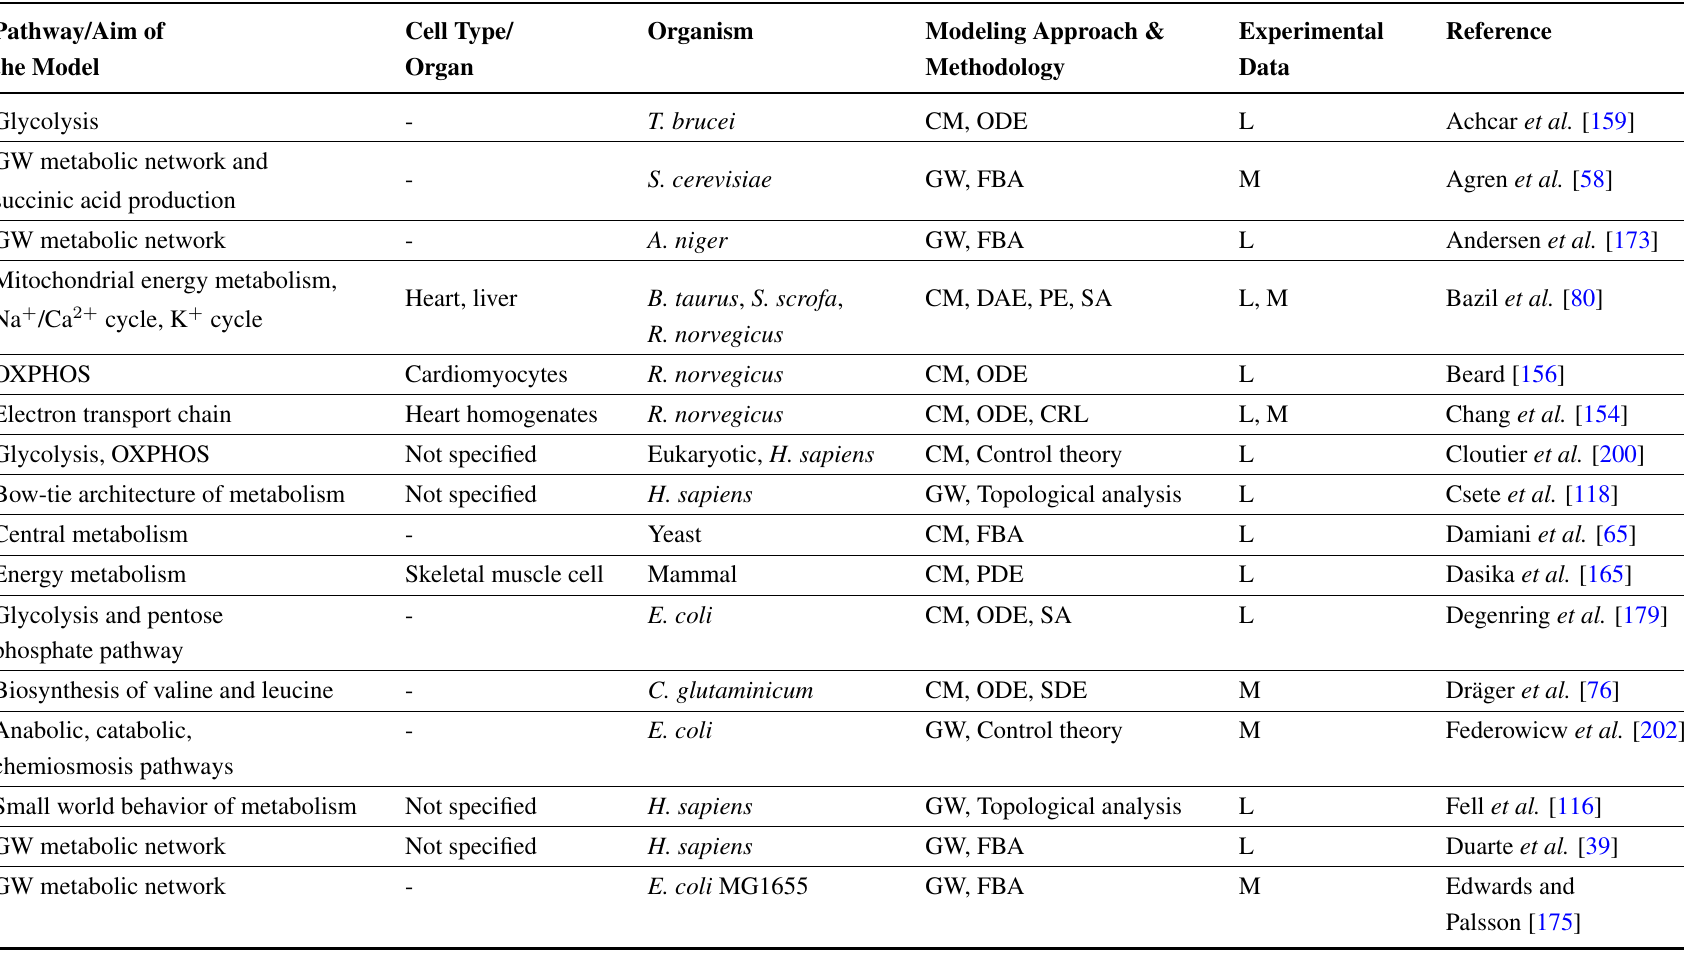
Table 1. Overview of some recent literature papers on the modeling and computational analysis of